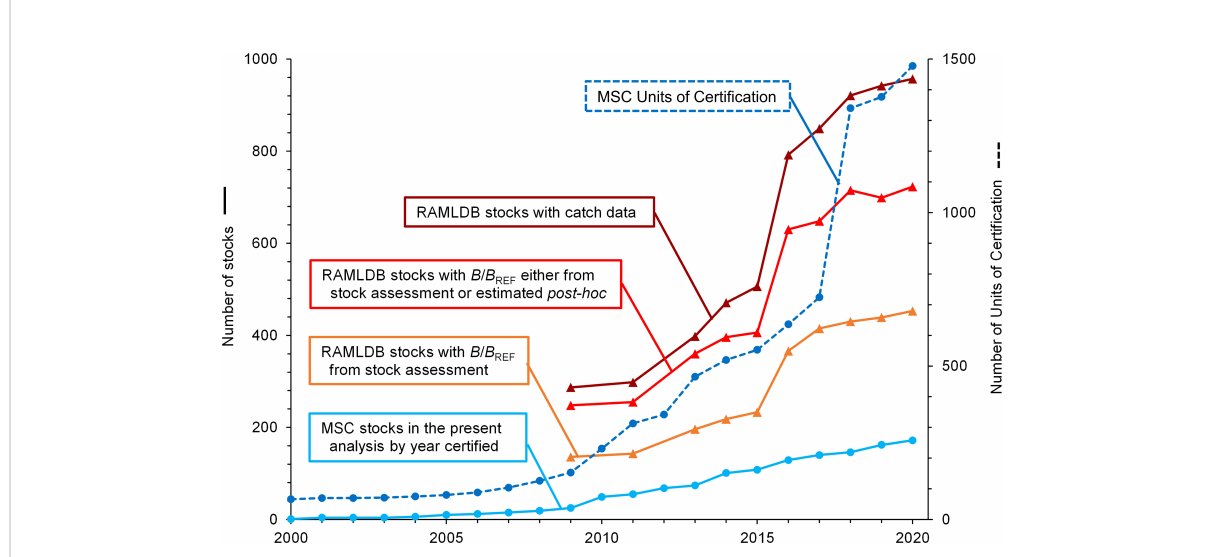
FIGURE 1 Growth of Marine Stewardship Council (MSC) program and RAM Legacy Stock Assessment Database (RAMLDB) over two decades. RAMLDB counts (reds; on left axis) show the end-of-year number of stocks with available catch data and number of stocks with B / B MSY time series available. MSC series (blues) show (on right axis) the end-of-year number of UoCs (which are the units evaluated separately under a certi fi cate, identi fi ed by the target stock combined with the fi shing method/gear and fi shing practice, including vessel(s), pursuing that stock) and (on left axis) number of stocks in analyses here that are linked to ≥ 1